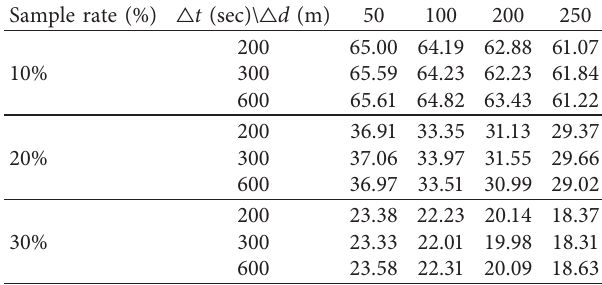
Table 4: MAPE by sample rate, unit section, and unit time of scenario 1 (numerical evaluation).